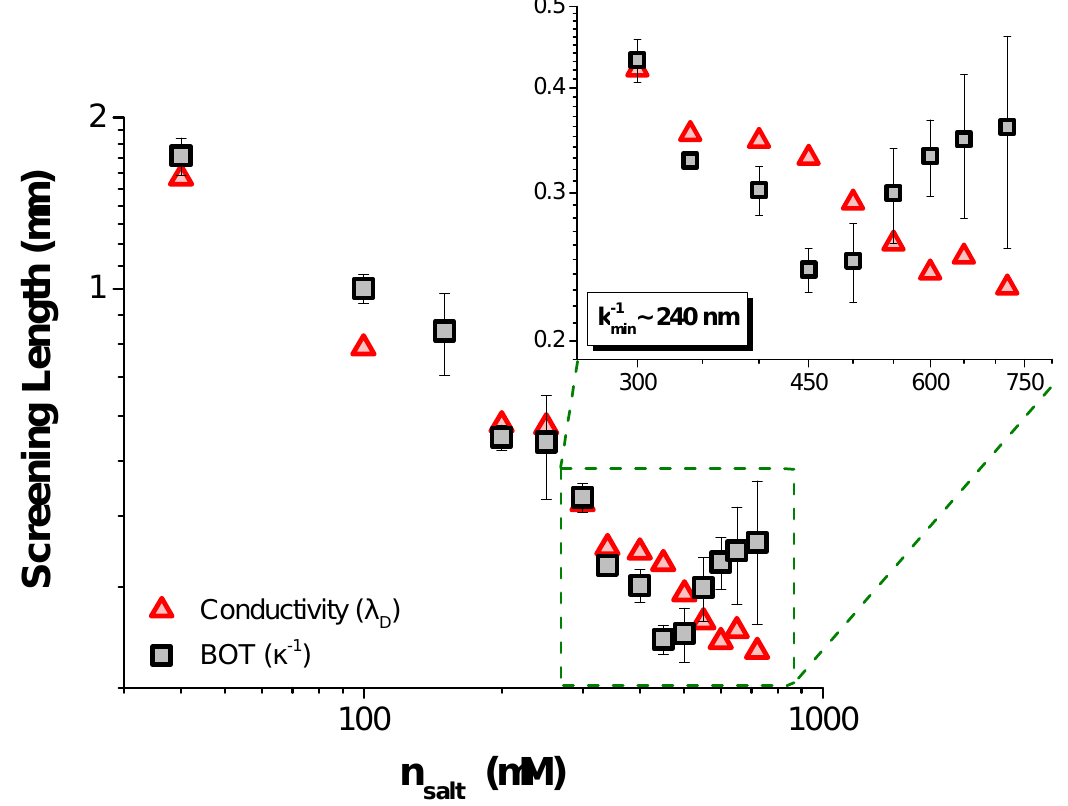
Figure 2. The screening length κ − 1 measured from BOT data (black squares) with the Debye length λ (red triangles) determined by